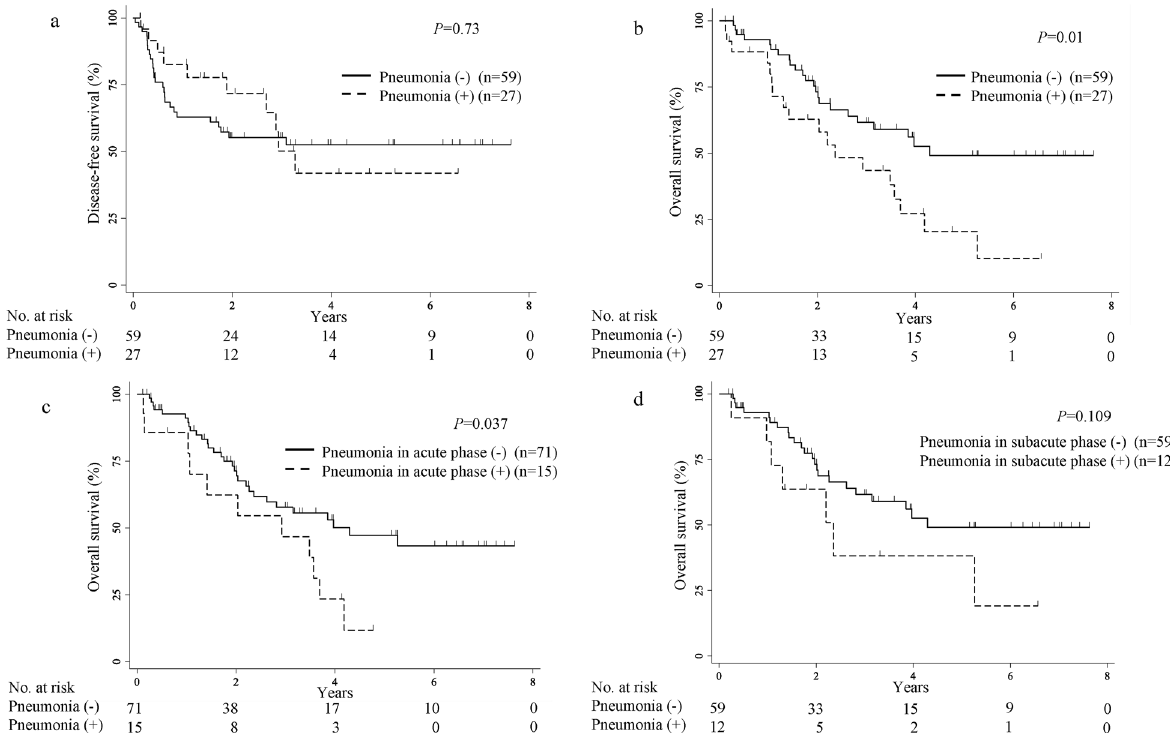
Figure 1. Kaplan–Meier survival curves with log-rank test. ( a ) Comparison of disease-free survival after esophagectomy between patients with pneumonia and those without pneumonia. ( b ) Comparison of overall survival after esophagectomy between patients with pneumonia and those without pneumonia. ( c ) Comparison of overall survival after esophagectomy between patients with pneumonia in the acute phase and those without pneumonia in the acute phase. ( d ) Comparison of overall survival after esophagectomy between patients with pneumonia in the subacute phase and those without pneumonia.